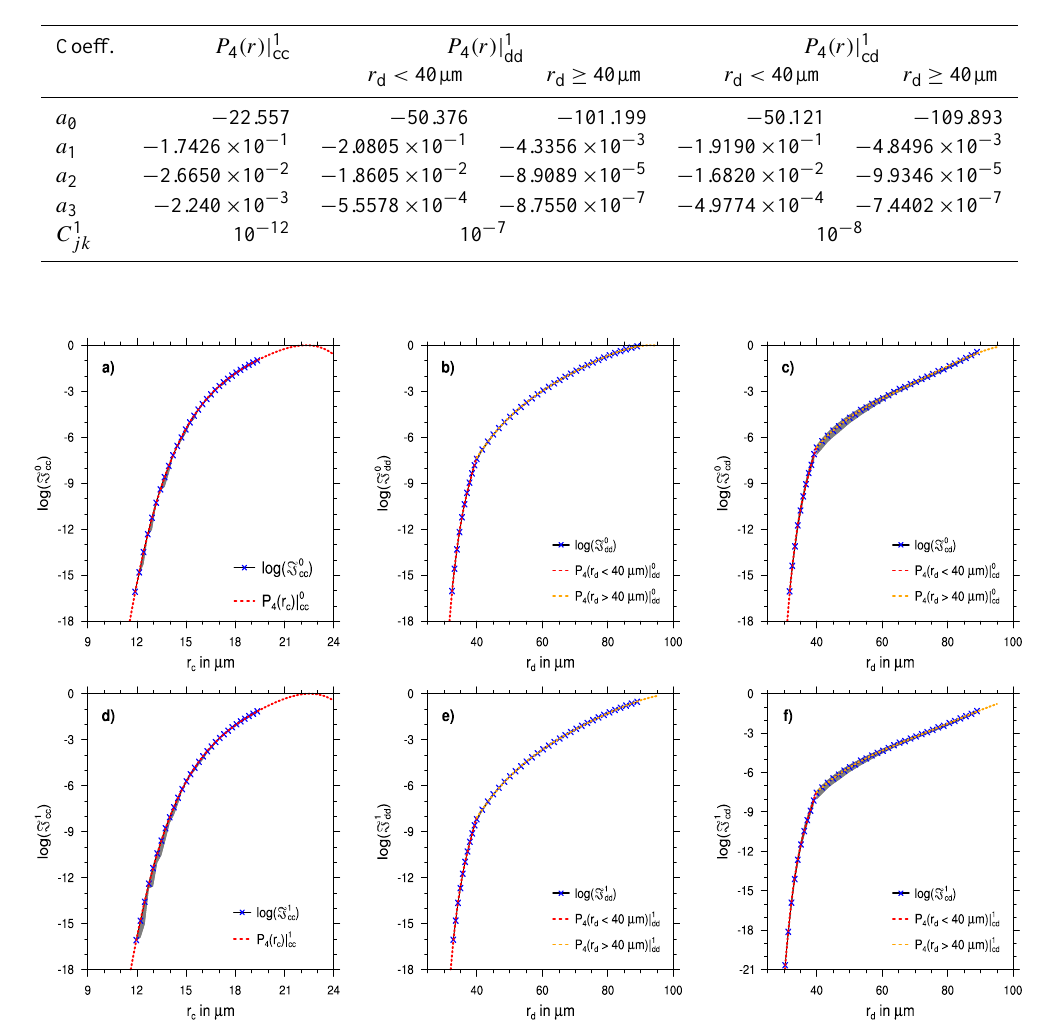
Table A2. The coefficients and scaling used in the four parameter polynomials (cf. Eq. A6) for approximating the first moment, i.e., n = 1, of the integrals in Eqs. (A3)–(A5).